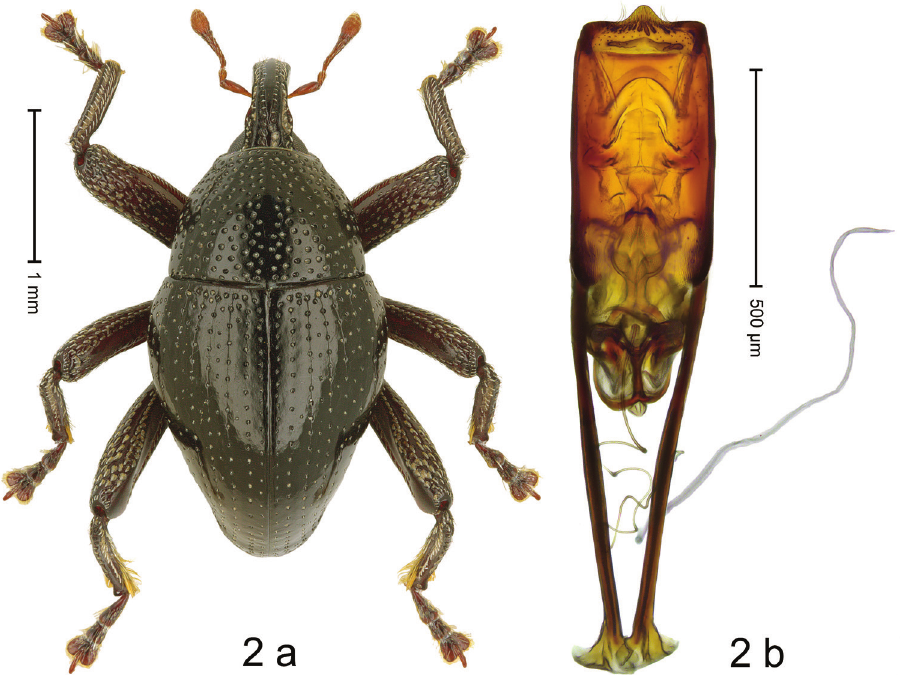
Figure 2. Trigonopterus ancora sp. nov., holotype a habitus b penis.